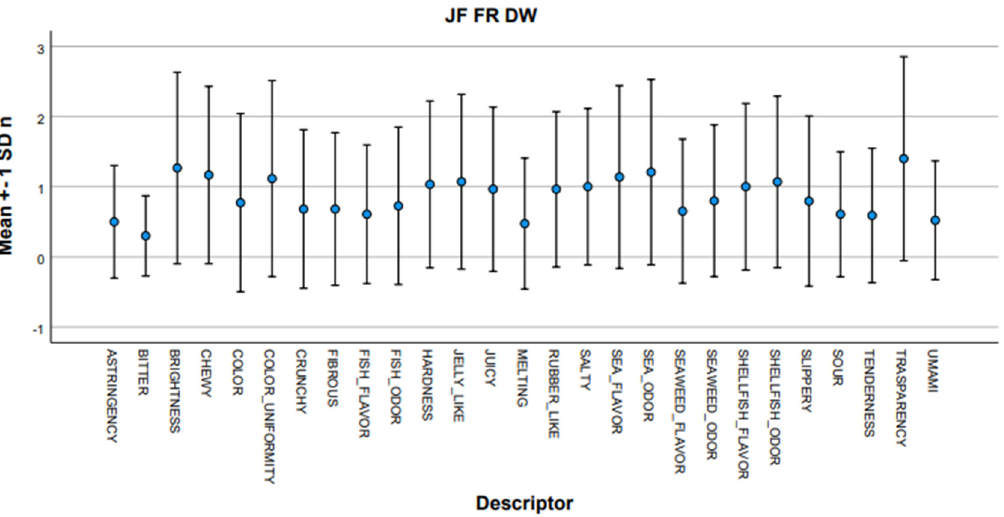
Figure 4. Error bar of the intensity mean score for descriptors selected for sample JF-FR-DW. Bars